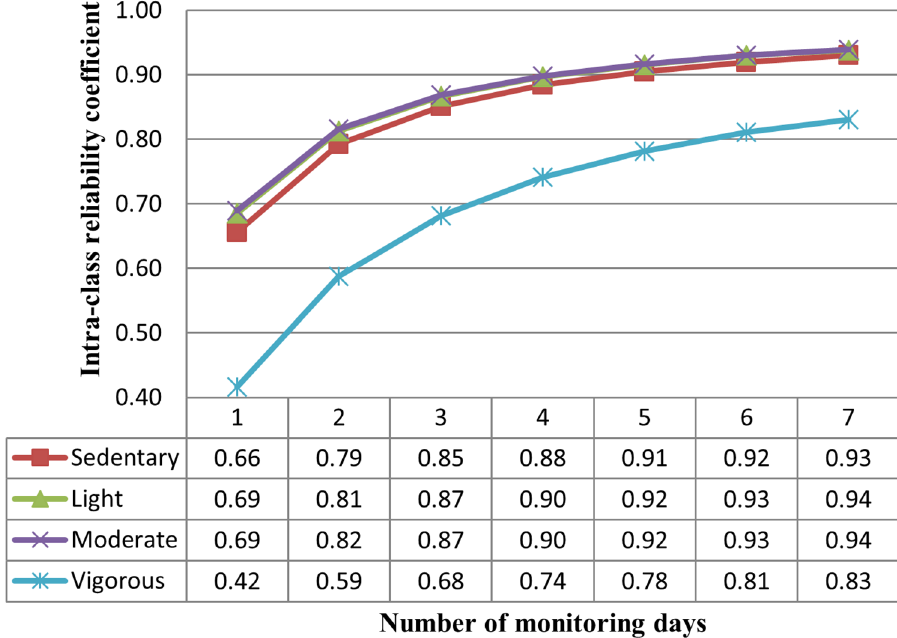
Fig 1. Reliability coefficient for number of days monitoring. Fig 1 illustrates the reliability coefficient associated with different length monitoring frames. The results propose that between 59 – 82%, 68 – 87%, 74 – 90% and 78 – 92% of variance was explained for by using 2 days, 3 days, 4 days and 5 days monitoring to represent 7 days of habitual activity.